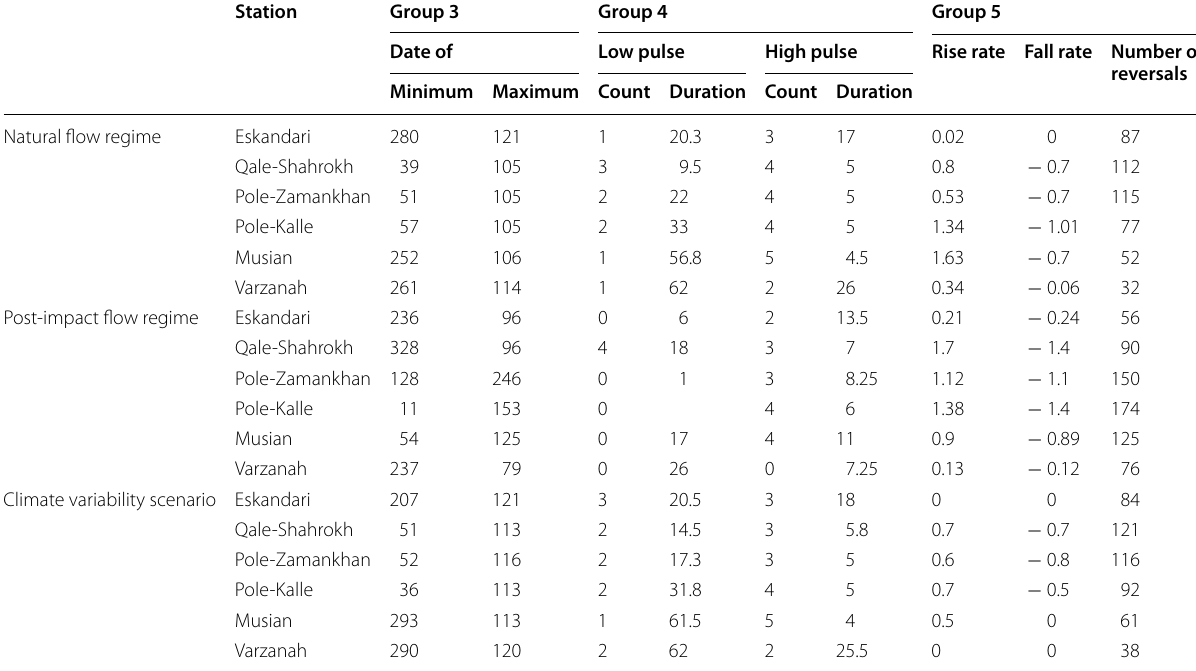
Table 2 Group 3, 4 and 5 of IHA parameters for natural flow regime, post-impact flow regime and flow regime under the impact of climate variability